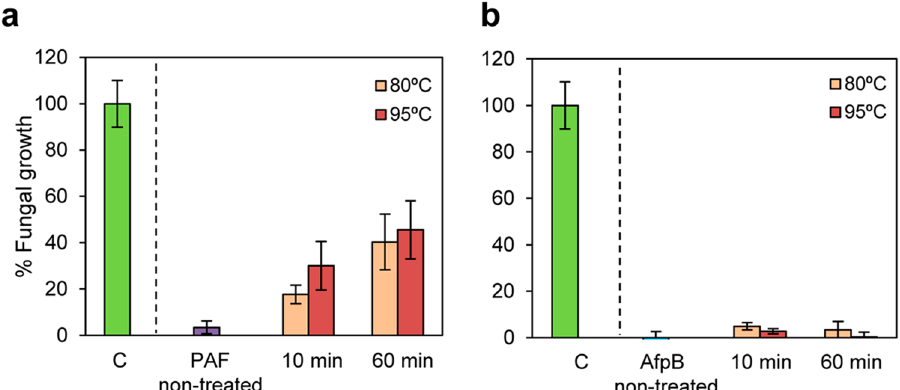
Figure 7. Effect of heat treatment on the antifungal activity of PAF and AfpB. PAF ( a ) and AfpB ( b ) (100 and 6.5 µ g/ml, respectively) were exposed to 80 and 95 °C for 10 and 60 min, respectively. Values represent the percentage of growth (%) of P . digitatum in the presence of non-treated and treated protein compared to P . digitatum in the absence of protein (control, C ). Data show mean ± s.d. OD 600 of triplicate samples.